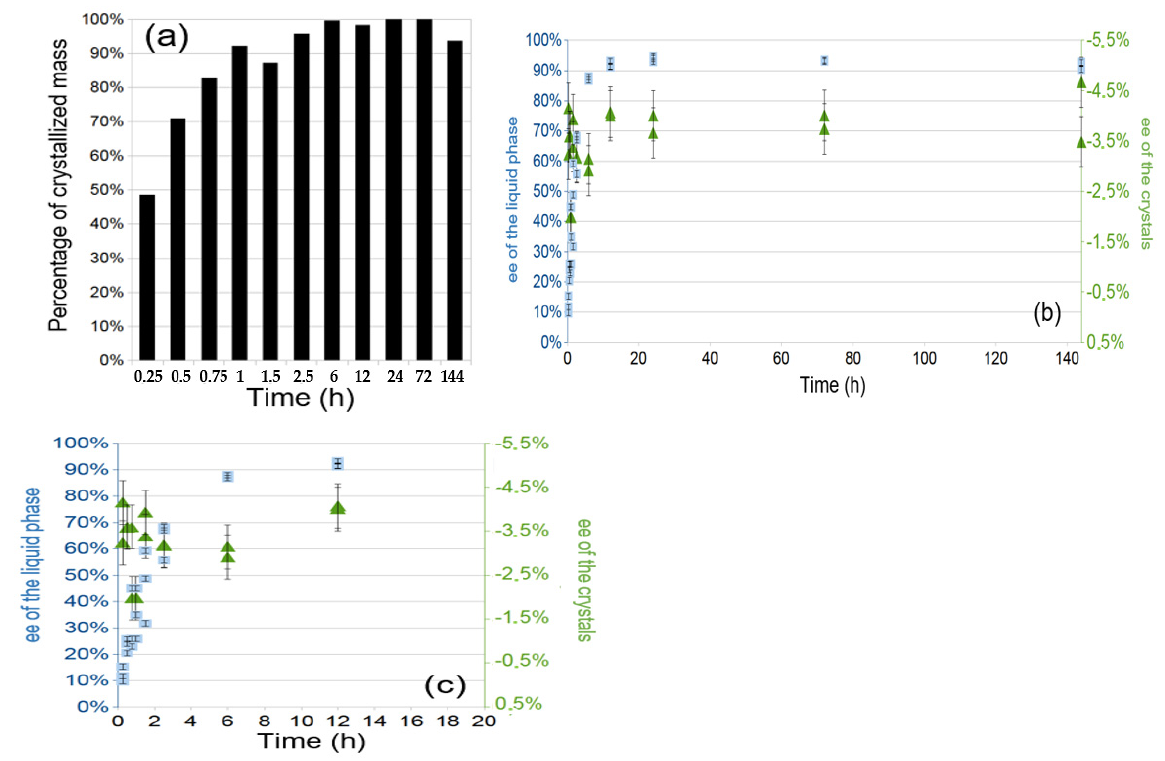
Figure 3. ( a ) Mass percentage of deposited ArgFum crystals as a function of time (expressed against the expected mass). ( b ) Monitoring of the ee of the liquid (blue squares) and solid (green triangles) phases during ArgFum PE. Each point represents the average values and standard deviations obtained for at least 3 identical experiments. ( c ) Enlargement of the first stage of the process.